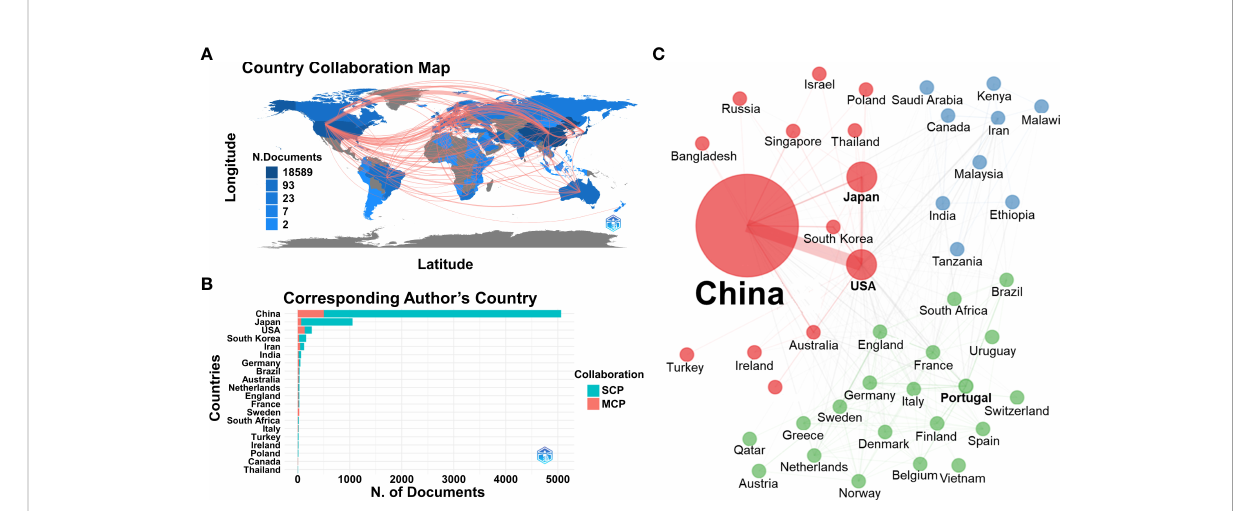
FIGURE 3 (A) World map showing the national collaborations and the volume of related articles. (B) Top 20 corresponding author ’ s countries with the highest number of related articles. SCP, Single country publications; MCP, Multiple country publications. (C) Network of national collaborations (color indicated clusters, circle size indicated publication number, thickness of lines indicated collaboration